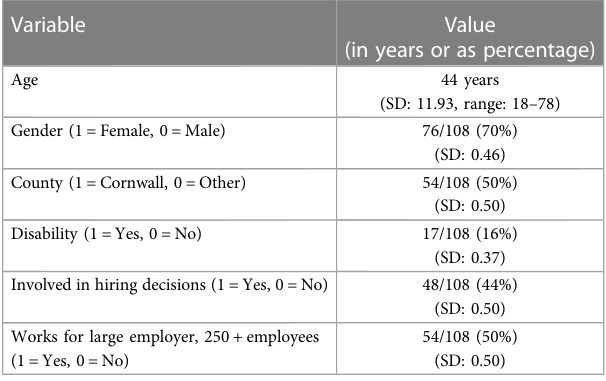
TABLE 2 Participant descriptive statistics ( N =108).